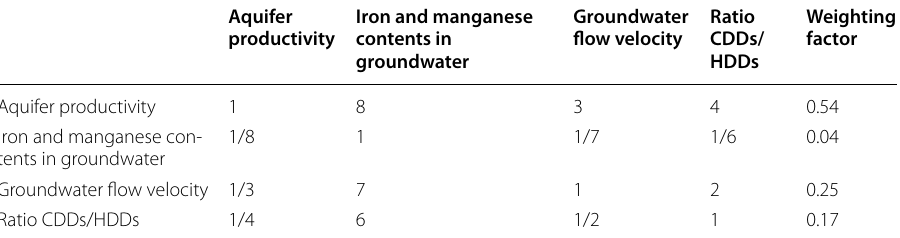
Table 3 Pairwise comparison matrix of the four criteria included in the potential study and their respective weighting